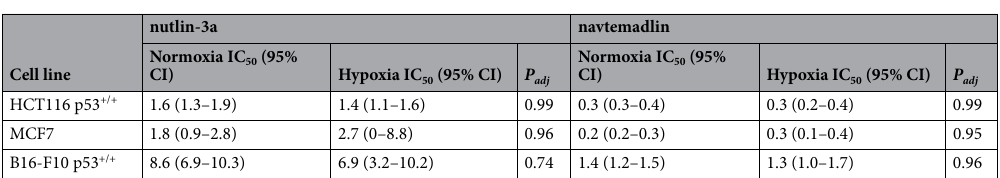
Table 3. Potencies of nutlin-3a and navtemadlin measured under normoxic and hypoxic conditions in cancer cell lines expressing wild-type p53. Potency was calculated as the concentration of drug that reduced cell growth by 50% of the untreated control (IC 50 ), as measured by a cellular viability assay. Cellular confluence was measured after 72 h of exposure to 10 drug concentrations. CI confidence interval.